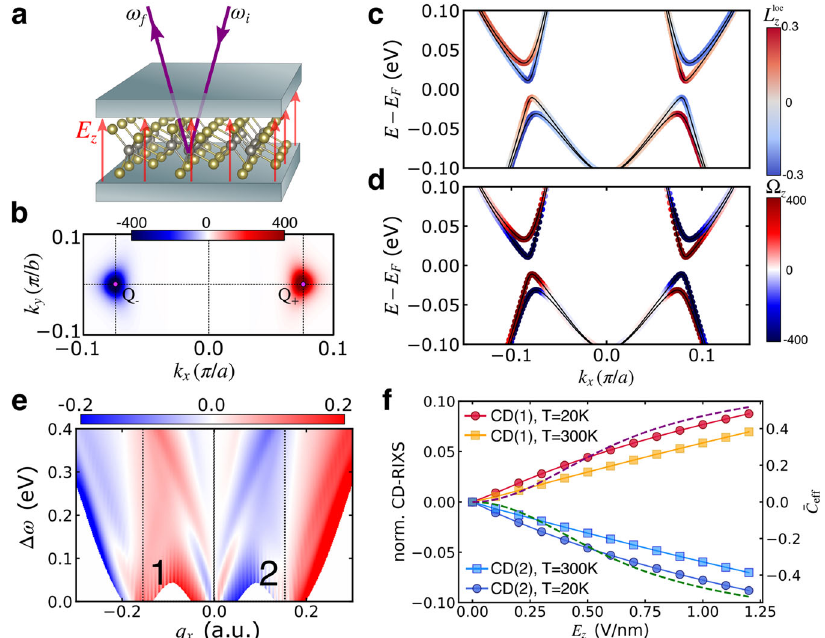
Fig. 5 Field-induced Berry curvature and circular dichroism from 1T 0 -MoS 2 . a Sketch of the setup for observing electrically switchable Berry curvature by RIXS. b Berry curvature Ω z of the bottom conduction bands in the vicinity of the Q ± points for E z = 0.4 V/m. c Fat-band representation of the local OAM L loc z (color map) along the X- Γ -X path for E z = 0.4 V/m. d Similar to c , but the color indicates the Berry curvature Ω z . e Normalized CD-RIXS signal ( I LCP − I RCP )/( I LCP + I RCP ) for 2 θ = 130 ∘ and unpolarized outgoing photons. The rectangles denoted by 1 and 2, respectively, represent the phase space where almost-direct transitions to the bottom conduction band (CB) are the dominant processes. f Integrated CD-RIXS signal (normalized over the total intensity) in the regions of interest 1, 2 in e (symbols), compared to the Berry curvature C eff of the bottom CB integrated region of the BZ shown in b